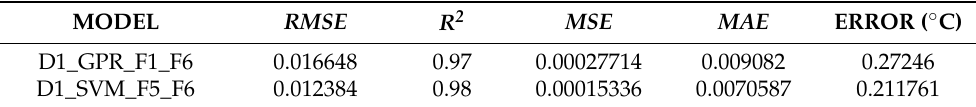
Table 6. D1 Validation Results for F1-F6 and F5, F6 Model